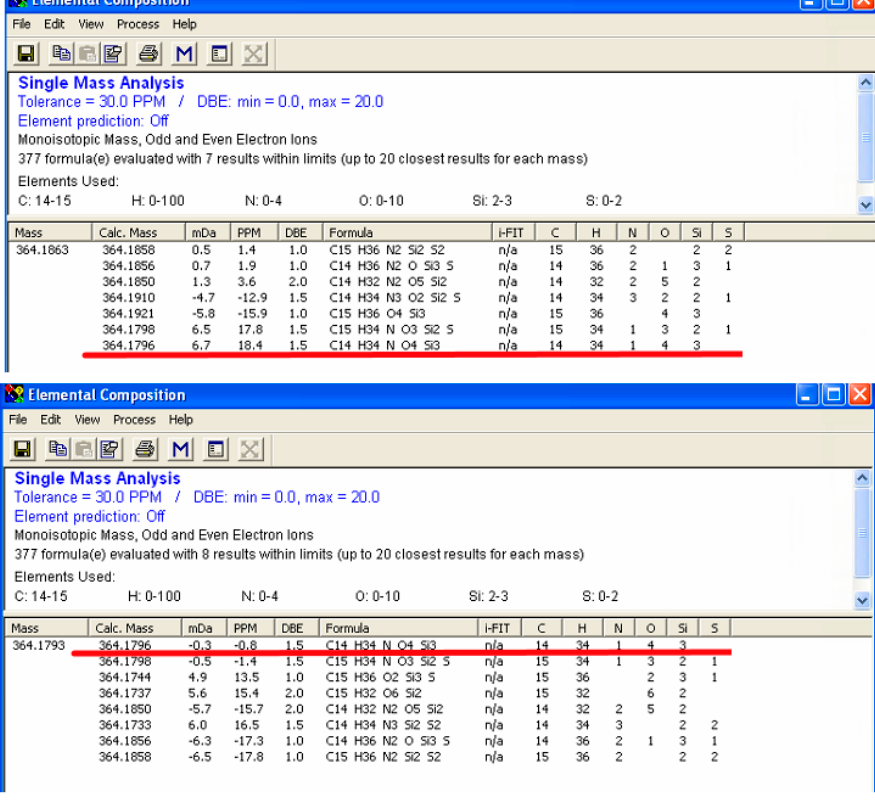
Figure 2. Resolution comparison between GC-Orbitrap/MS and GC-TOF/MS (triple-silylated glutamic acid). Higher resolution helps to reduce possible formulae based on the molecular weight. After considering the number of carbons in the metabolite and silylation groups, the number of carbons was set to 14–15, and the number of silicon atoms was set to 2–3, allowing for possible hydrogen, oxygen, nitrogen and sulfur. The metabolite was identified as triple-silylated glutamic acid with molecular formula as C 14 H 34 NO 4 Si 3 . The accurate mass is 346.1796. The mass derivation for GC-TOF/MS (upper) was 18.4 ppm and ranked as the seventh candidate, while the mass derivation was for GC-Orbitrap/MS (lower) was − 0.8 ppm, and ranked as the first of all possible candidates.